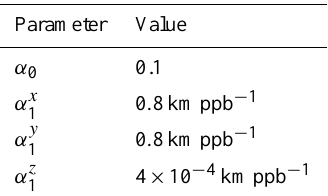
Table 1. Regularisation strength for 3-D retrieval